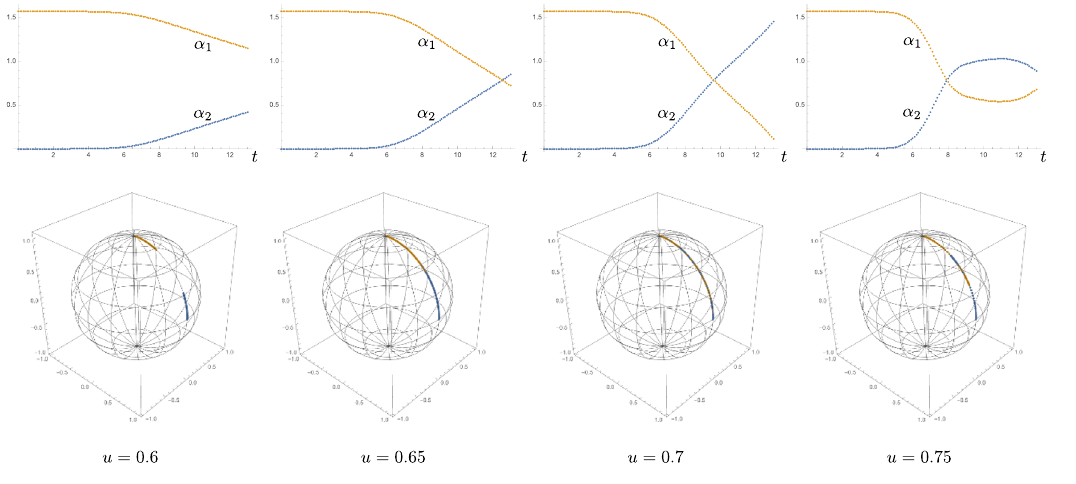
Figure 11 . Evolutions of internal orientations α 1 , 2 of the orthogonal vortices with the velocities u = 0 . 6 , 0 . 65 , 0 . 7 , 0 . 75 below the